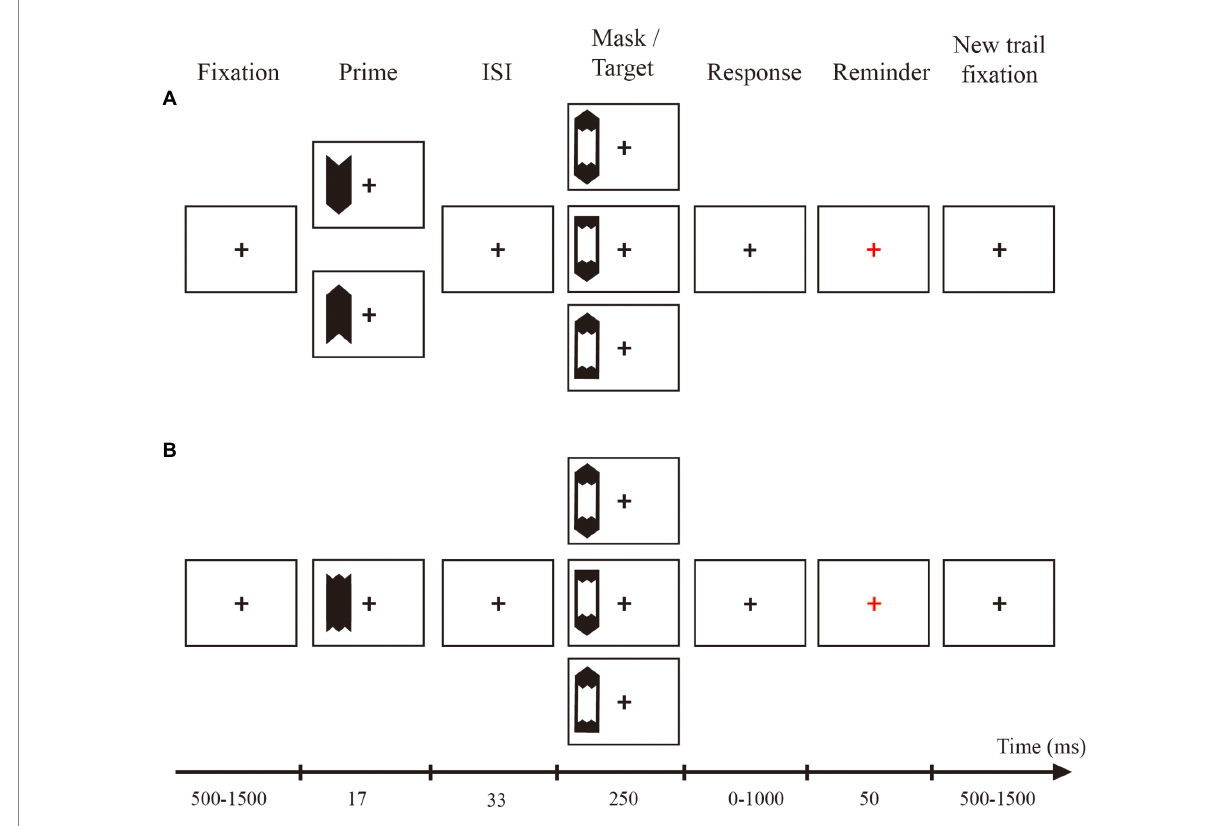
FIGURE 2 Schematic of the trial procedure and stimuli in the training task. During the training phase, the presentation position of the prime and target was 1.38 ° to the left or right of the fixation point, and the arrow pointing was up or down. The size and shape of the prime and target were always the same. Panel (A) shows the specific sequence of each trial during the training phases of Experiments 1, 3 and 4. In these three experiments, the prime always pointed up or down. Panel (B) shows the specific sequence of each trial during the training phase of Experiment 2 (control experiment). In Experiment 2, the prime arrow pointing direction was always “no